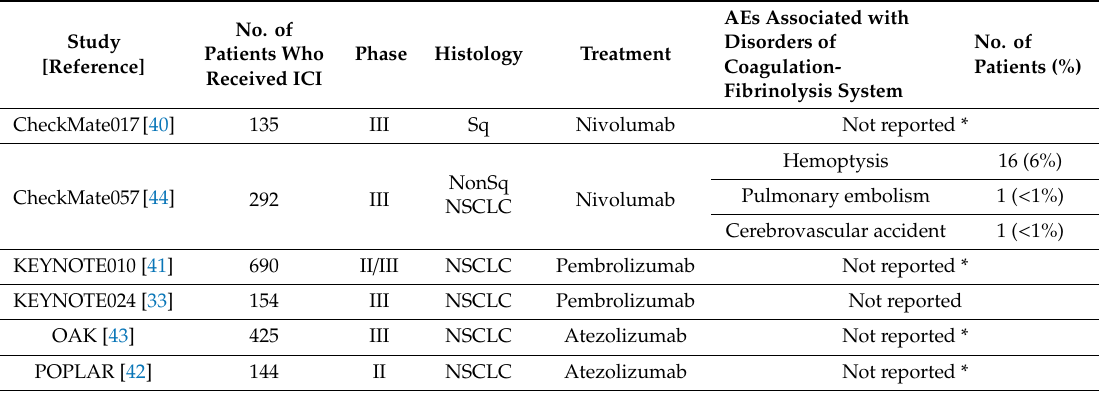
Table 3. AEs associated with disorder of coagulation-fibrinolysis system reported in clinical trials of ICIs in patients with advanced